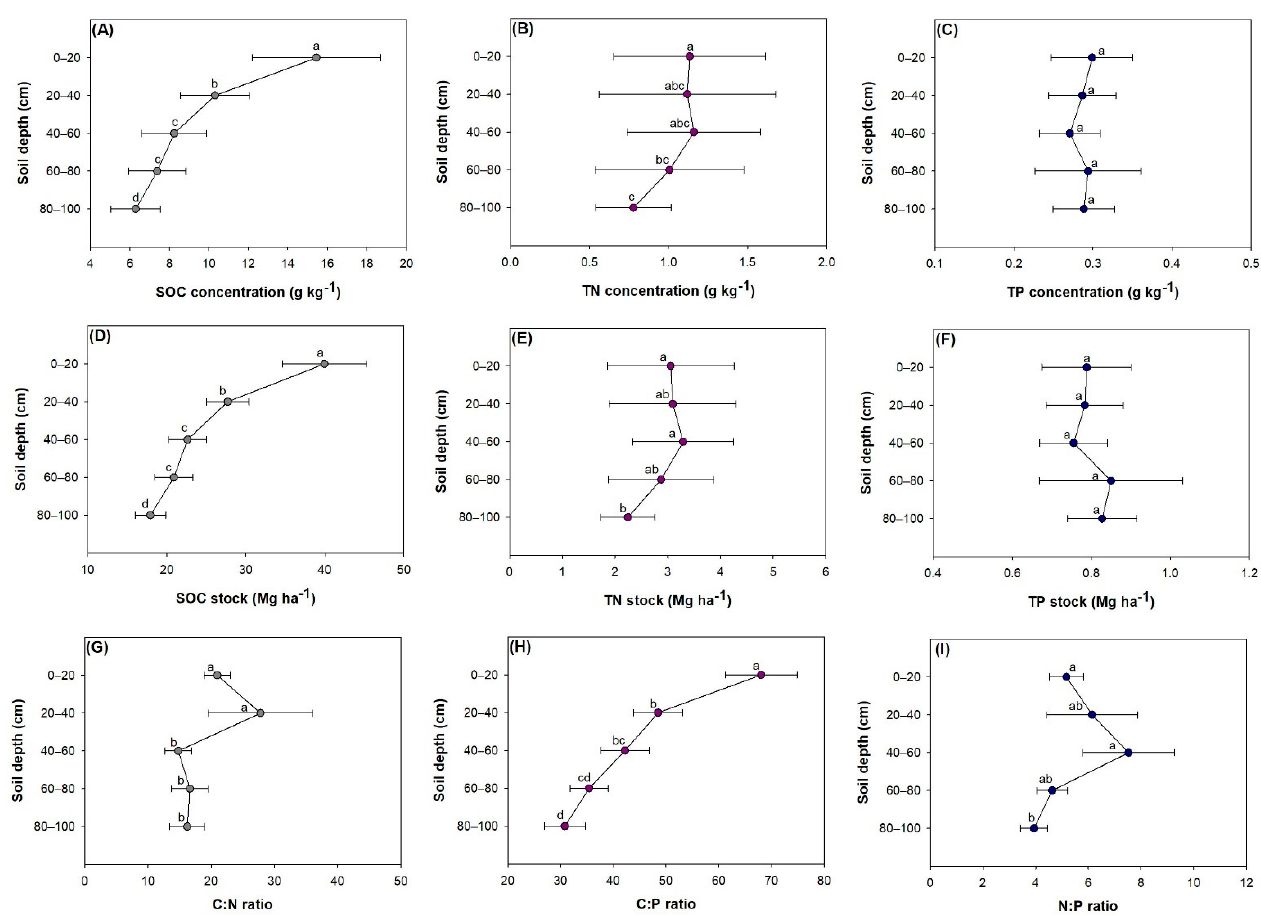
Figure 3. Differences in concentrations and stocks in soil organic carbon (SOC) ( A , D ), total nitrogen (TN) ( B , E ), and total phosphorus (TP) ( C , F ) and ratios of C:N ( G ), C:P ( H ), and (N:P) ( I ) in five soil layers at depths of 0–20 cm, 20–40 cm, 40–60 cm, 60–80 cm, and 80–100 cm in Yunfu, Guangdong province, South China. Bars indicate standard deviations. Different letters beyond bars indicate significant difference detected by Duncan test at 0.05 level.